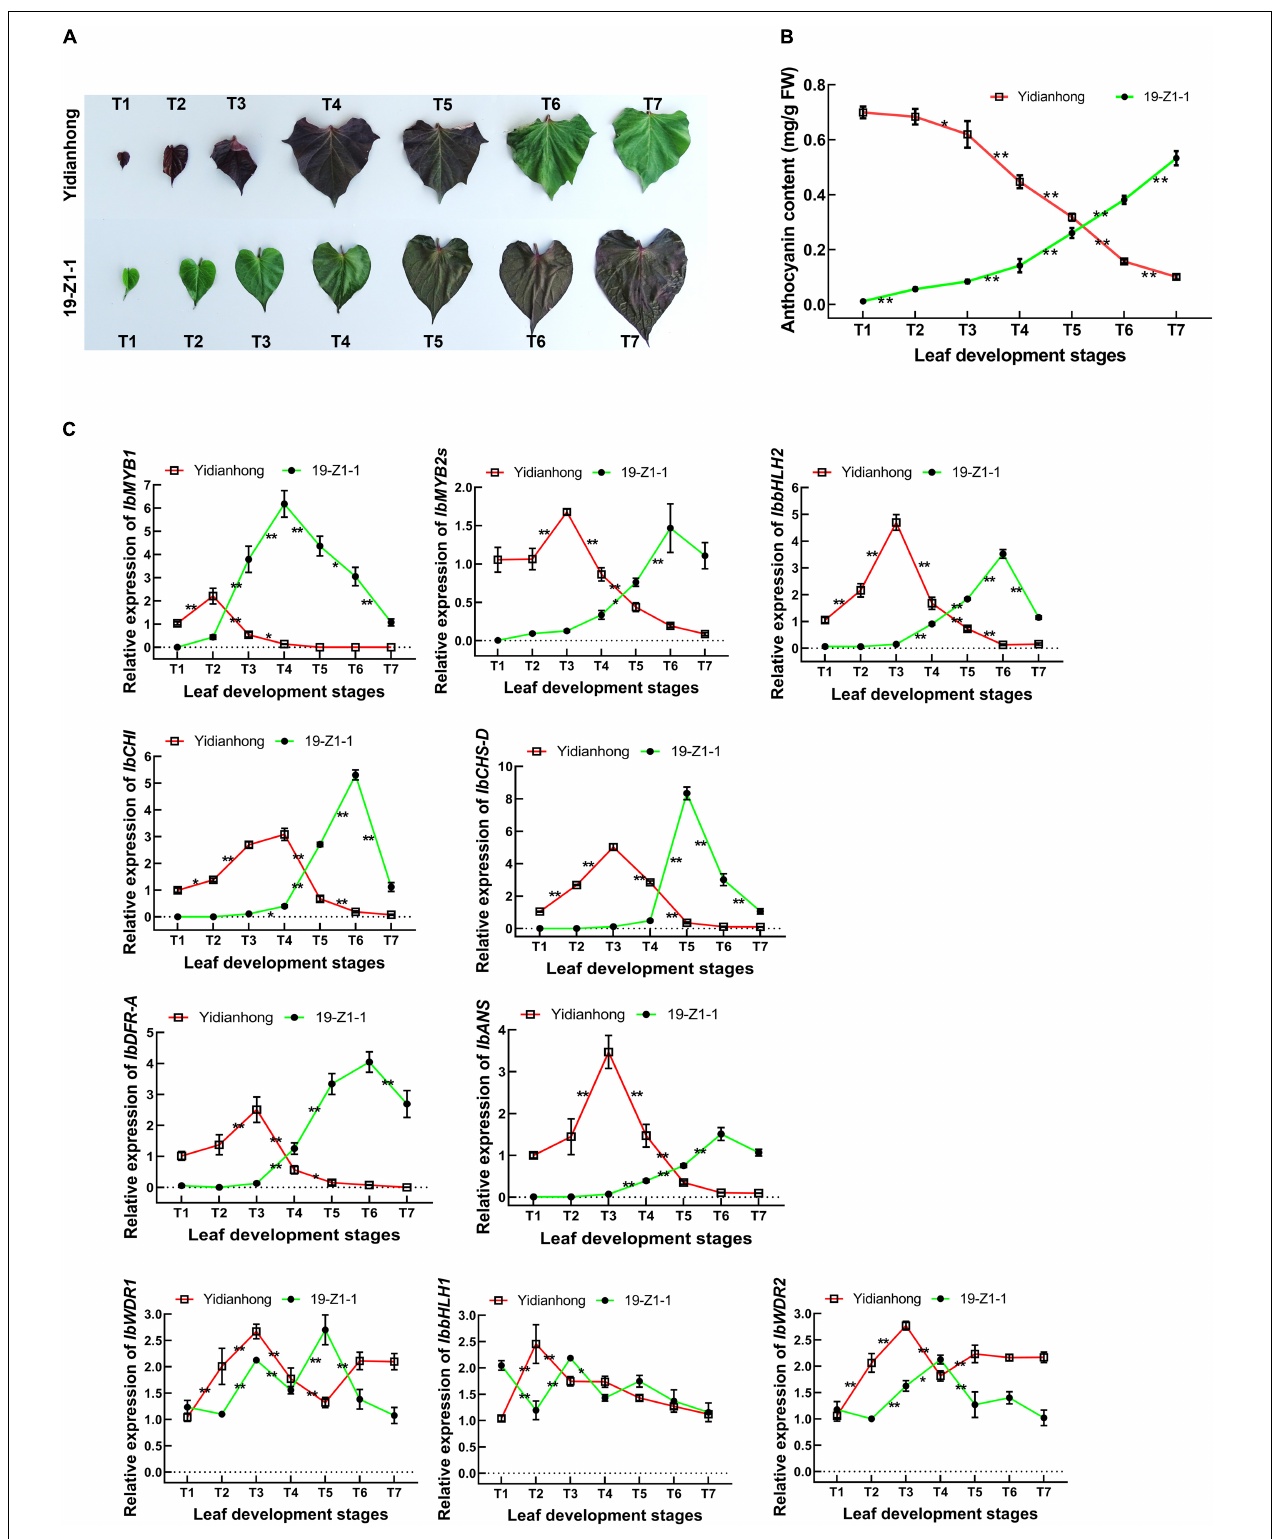
FIGURE 4 | Gene expression of anthocyanin biosynthesis was synchronous with the change of anthocyanin content in leaves. (A) Purple changes in the leaves of “19-Z1-1” and “Yidianhong”. (B) Anthocyanin content of leaves changed with the color depth of purple during the leaf development stage. * P < 0.05 and ** P < 0.01, n = 5. (C) Gene expression changes of anthocyanin biosynthesis by RT-qPCR. * P < 0.05, ** P < 0.01, n = 3.